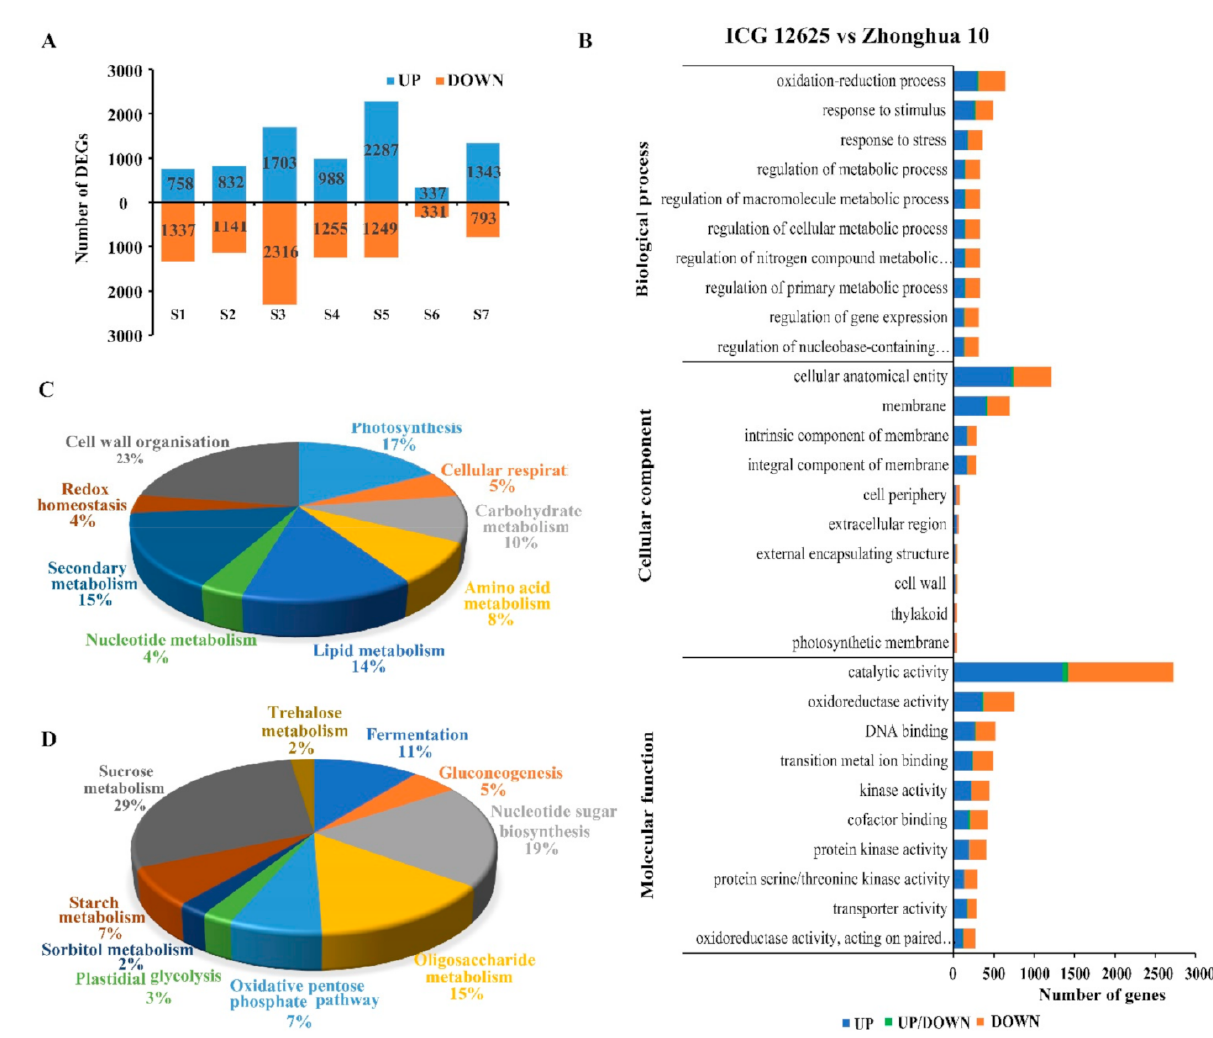
Figure 4. Differentially expressed genes between ICG 12625 and Zhonghua 10 at seven stages of seed development. ( A ) The number of upregulated (upper bars) and downregulated (lower bars) genes in ICG 12625 as compared with Zhonghua 10 at each stage of seed development. ( B ) Gene ontology analysis of DEGs. “UP/DOWN” means the genes were upregulated at one stage of seed development and downregulated at another stage of seed development. ( C ) The pie chart showing the proportion of genes involved in different metabolic pathways. ( D ) The pie chart showing the proportion of genes involved in carbohydrate